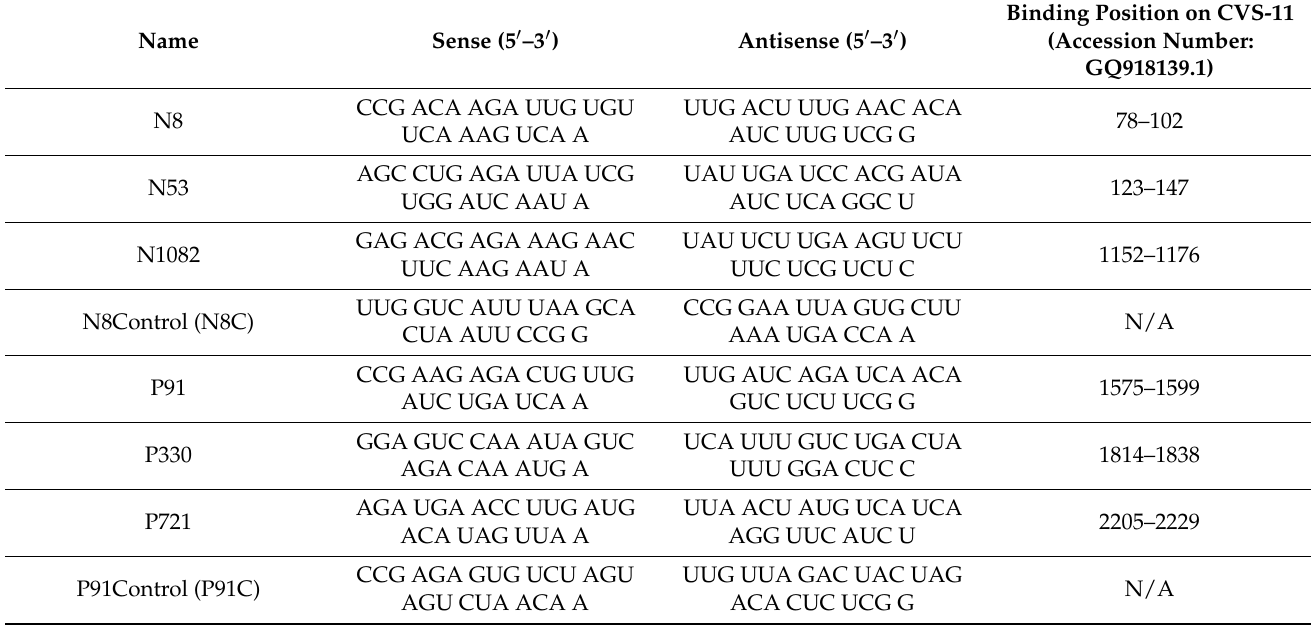
Table 2. Developed Stealth siRNAs targeting the N and P genes of RABV CVS-11.